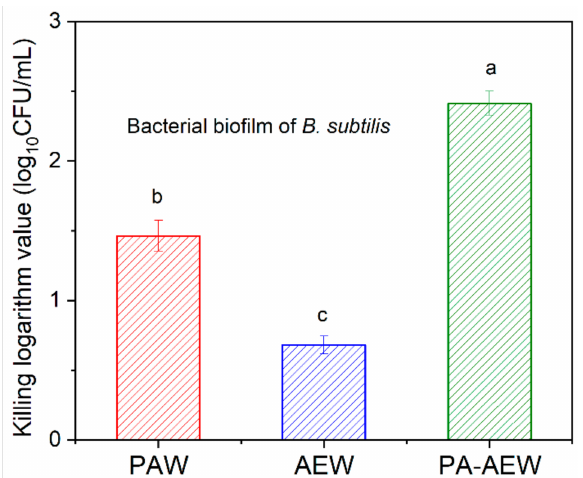
Figure 11. Sterilization effects of PAW, AEW and PA-AEW on the bacterial biofilm of B. subtilis . Values with different lowercase letters above graph bars represent a significant difference ( p <